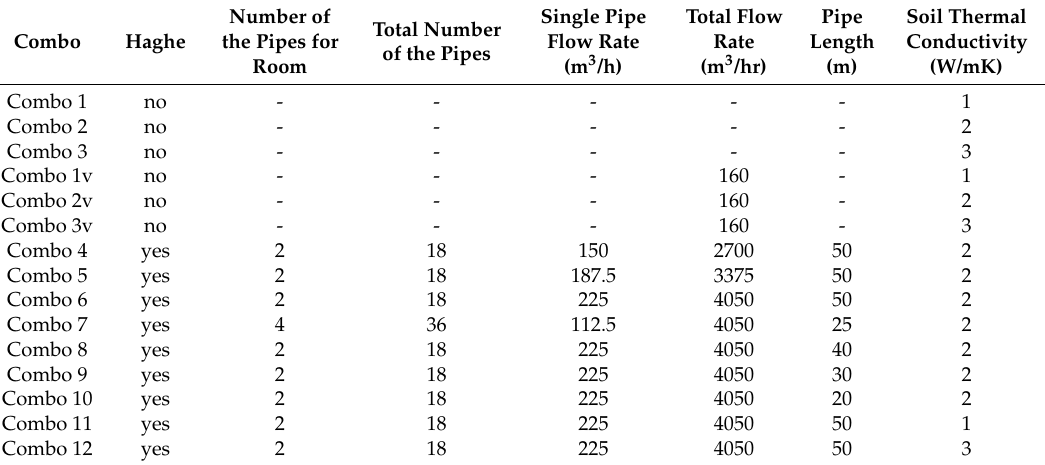
Table 7. List of